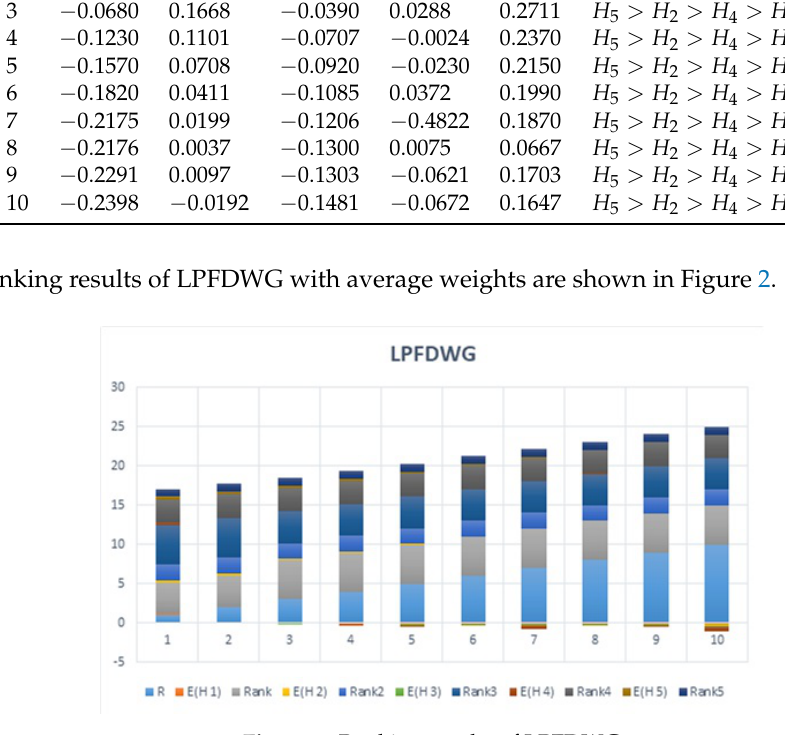
Figure 2. Ranking results of LPFDWG